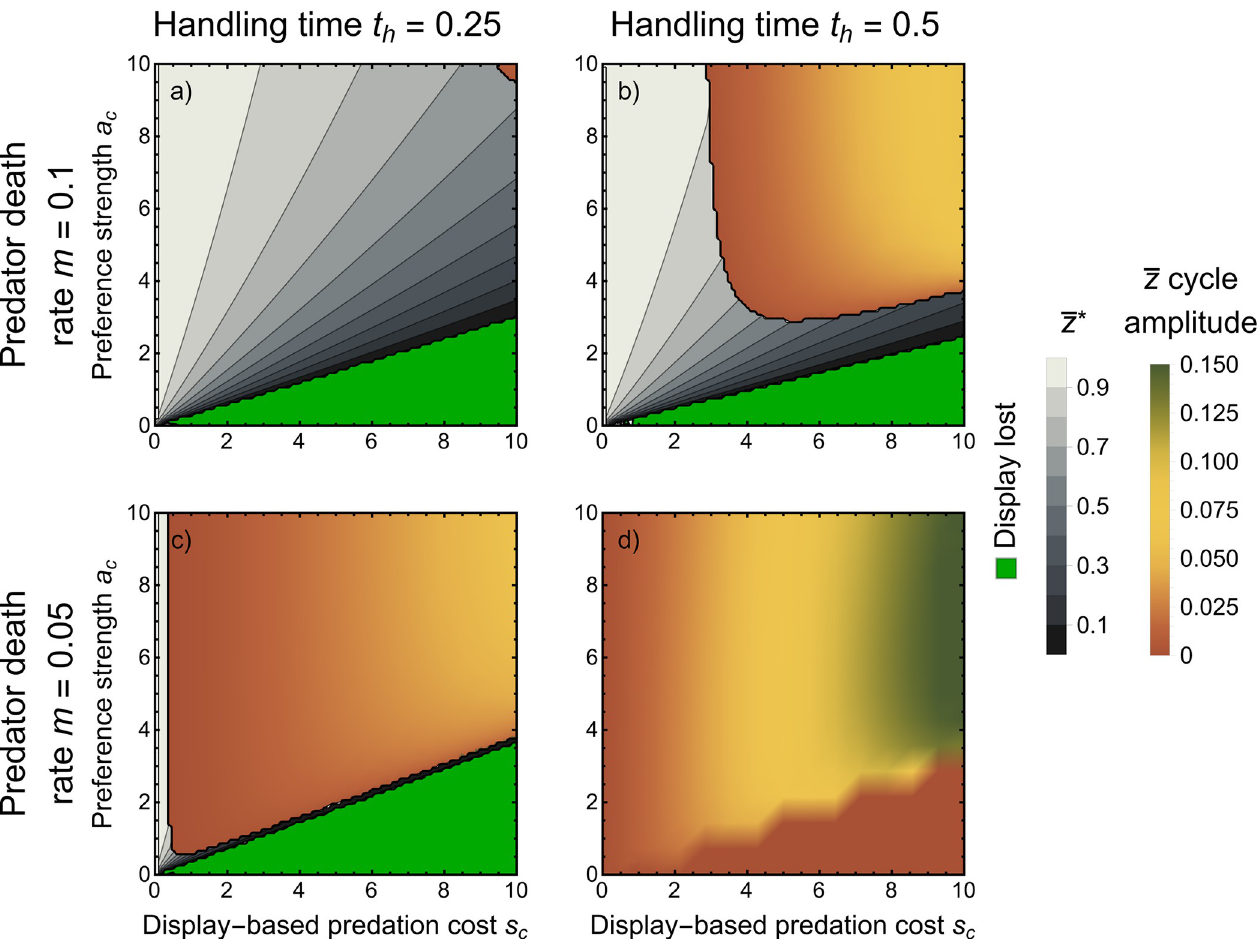
Fig 3. Eco-evolutionary outcomes from the continuous model. Horizontal axis is display-based predation cost s Each panel represents a different predator death rate m or handing time t h . Regions have the same meaning as Fig 2, except in grayscale regions, lighter colors correspond to higher display trait value at equilibrium and in dark green-yellow-orange regions dark green and yellow colors correspond to higher amplitude of cycles in the display trait (which correlates to period and the amplitude of cycles in other state variables; S2 Fig). Note that the trait is lost and cycles are purely ecological in the bottom right, rust-colored region of ( b ). r c = 2, b c = 5, σ = 0.1, c c = 0.1. This Figure can be generated using S1 Code.